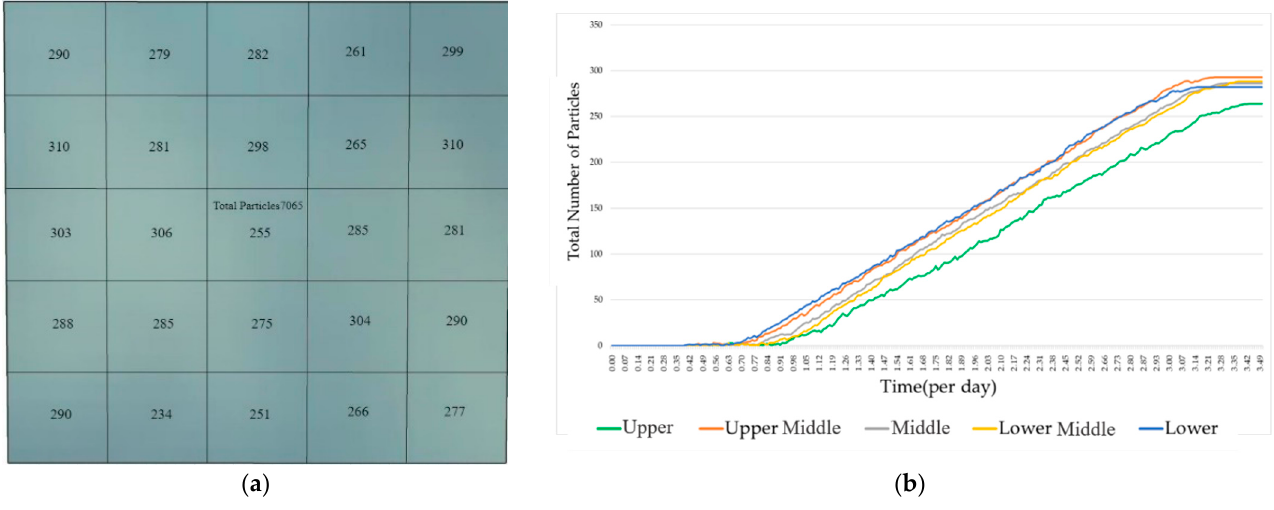
Figure 6. Dust particle distribution at an inclination angle of 23°. ( a ) The total number of particles in each area and ( b ) that over time on the solar panel surface.